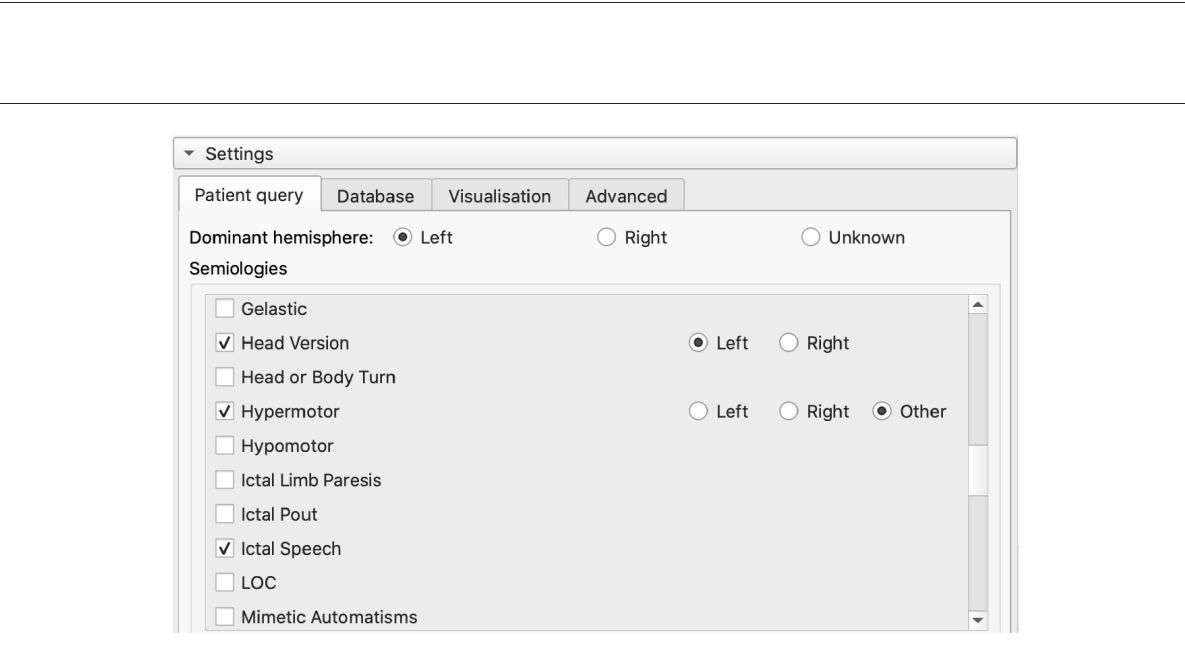
FIGURE3 List of pre-defined semiologies in the GUI. Users can select a semiology in the list or add a custom one. Custom semiologies are matched to a pre-defined semiology using regular expressions to map concepts associated with that